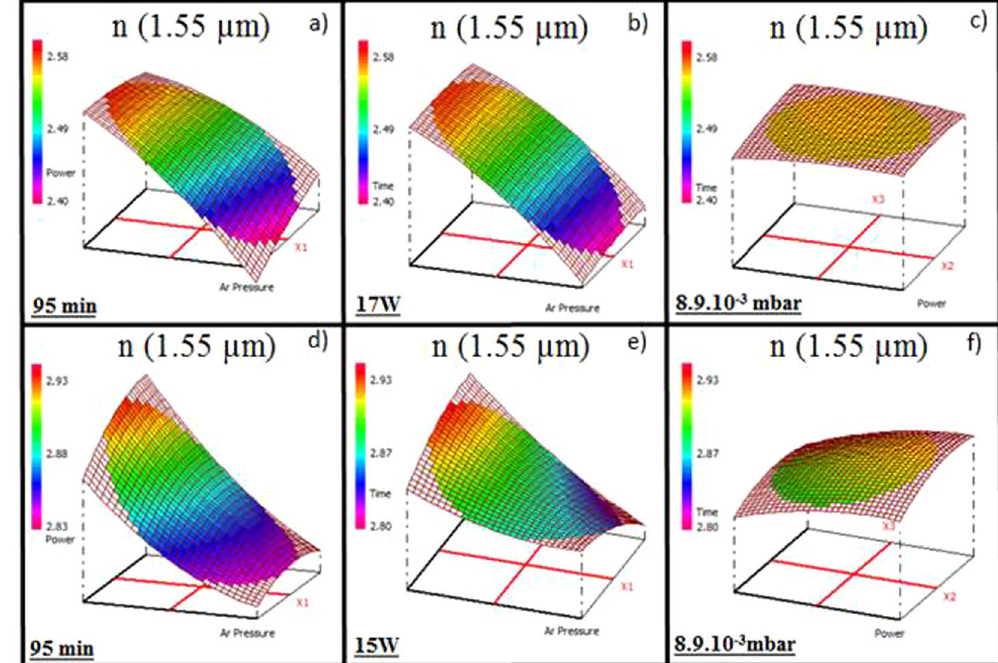
Figure 3. Variation of the refractive index (1.55 µ m) of the Ge 28.1 Sb 6.3 Se 65.6 thin films for ( a ) a fixed deposition time of 95 min, ( b ) a fixed working power of 17 W, ( c ) a fixed Ar pressure of 8.9.10 − 3 mbar and the